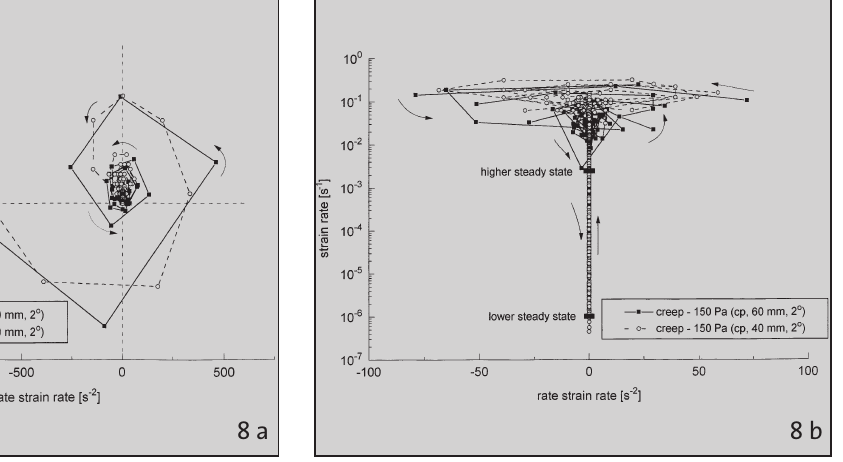
Figure 8: The experimental dependence, γ · ( γ ·· ) ; with time as parameter; a) normal scale, b) logarithmic scale (detail); lubricating grease at 20 o